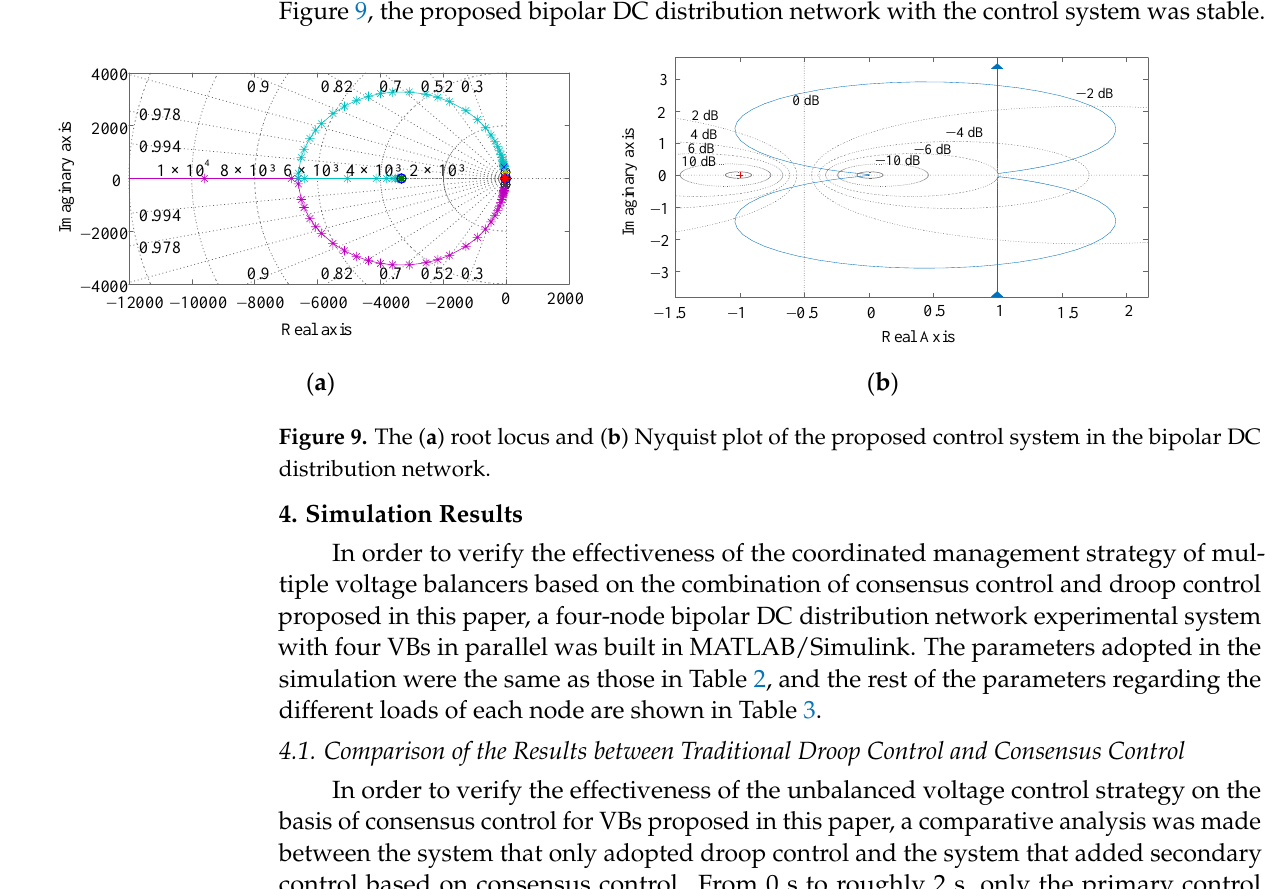
( b ) Figure 11. The effect of distributed consensus control combining primary control and secondary control on the average voltage of the ( a ) positive bus and ( b ) negative bus.